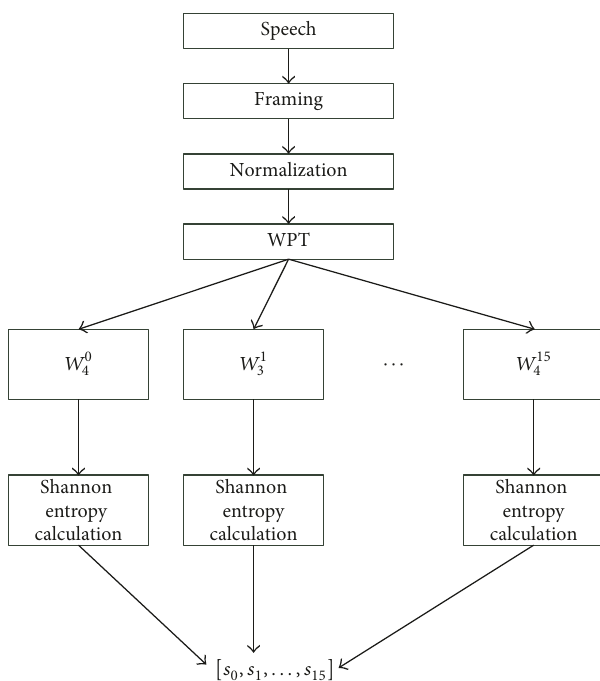
Figure 3: The flow chart of wavelet packet entropy.